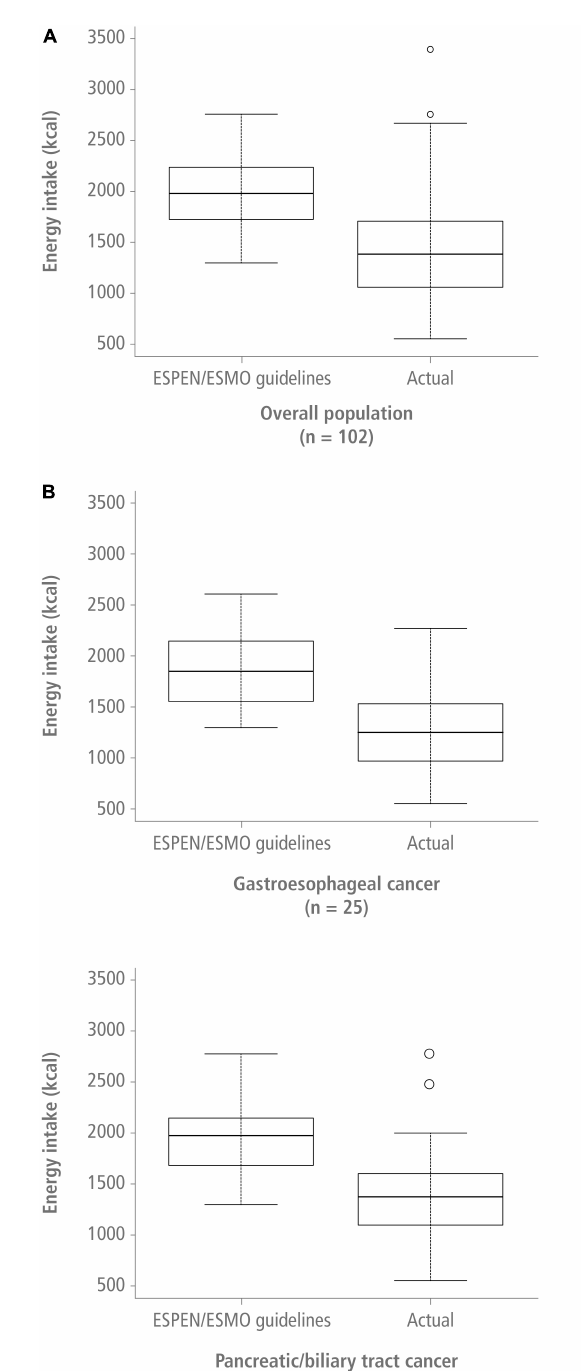
FIGURE2 Recommended energy intake (upper limit) vs. actual energy intake in the overall population [panel (A) ] and for the different cancer sites [panel (B) ] presented as kcal/day. ESMO, European Society for Medical Oncology; ESPEN, European Society for Clinical Nutrition and Metabolism.